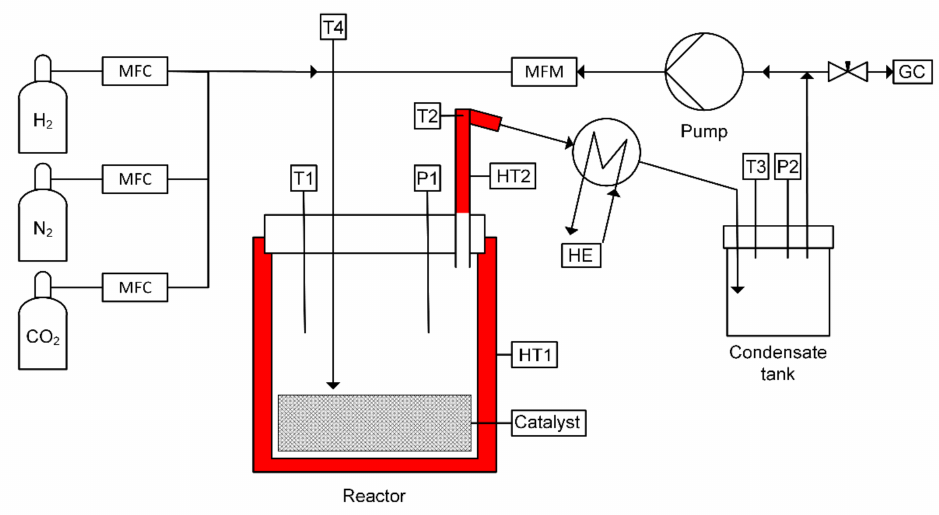
Figure 2. Experimental setup of the semi-continuous tank reactor with external recycle for the gaseous reactant stream and external condensation of condensable products in bench